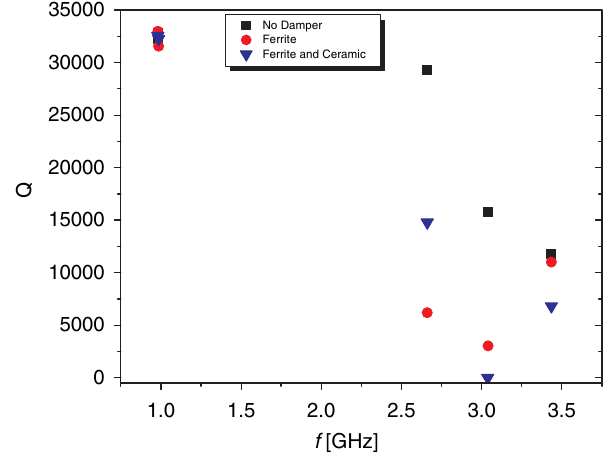
FIG. 30. Damping of dipole gun resonances (black) by ferrite alone (red) and by the ceramic/ferrite combination